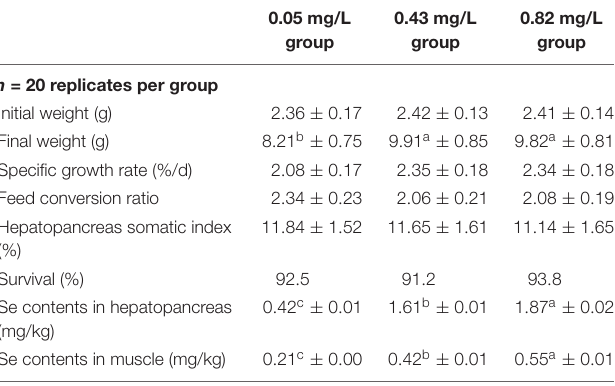
TABLE 3 | Growth and Se content in hepatopancreas and muscle of Chinese mitten crab ( Eriocheir sinensis ) fed dietary supplementation with cultured Potamogeton maackianus powder.